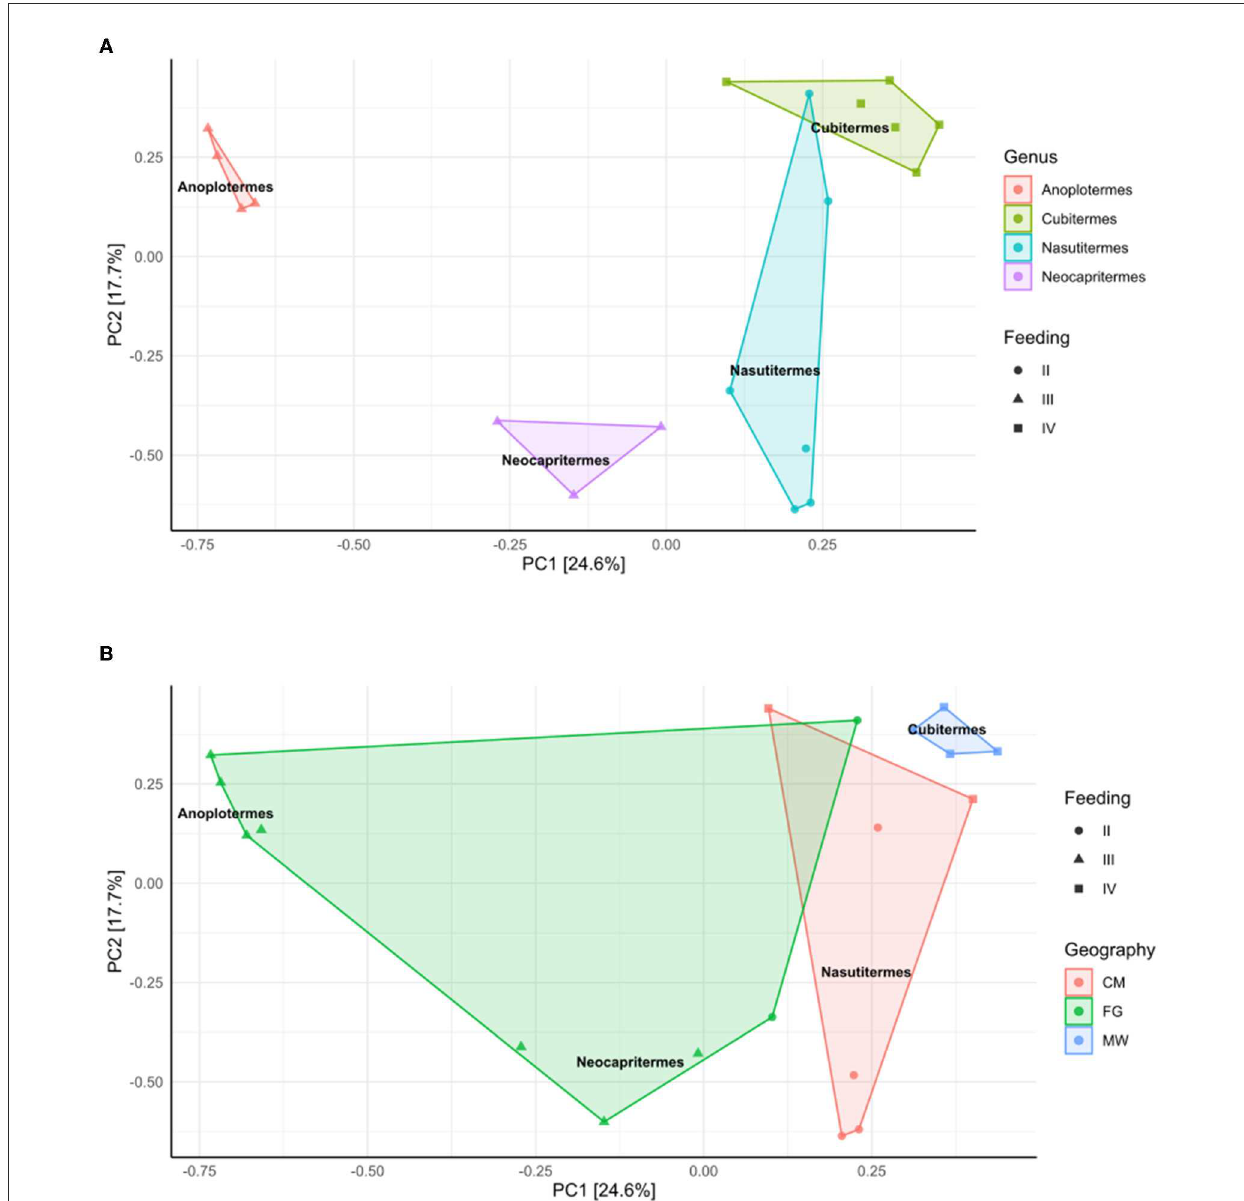
FIGURE3 PCA analysis with 16S data after elimination of samples with < 3 representatives per genus, and the tags from the negative sample control. (A) Samples were subjected to Hellinger transformation, sample constraint, and color were “Genus,” and shape by feeding strategy. (B) Samples were subjected to Hellinger transformation and the sample constraint was “Genus,” while sample color was geography and shaped by feeding strategy. Genera indications are kept as shown in Figure